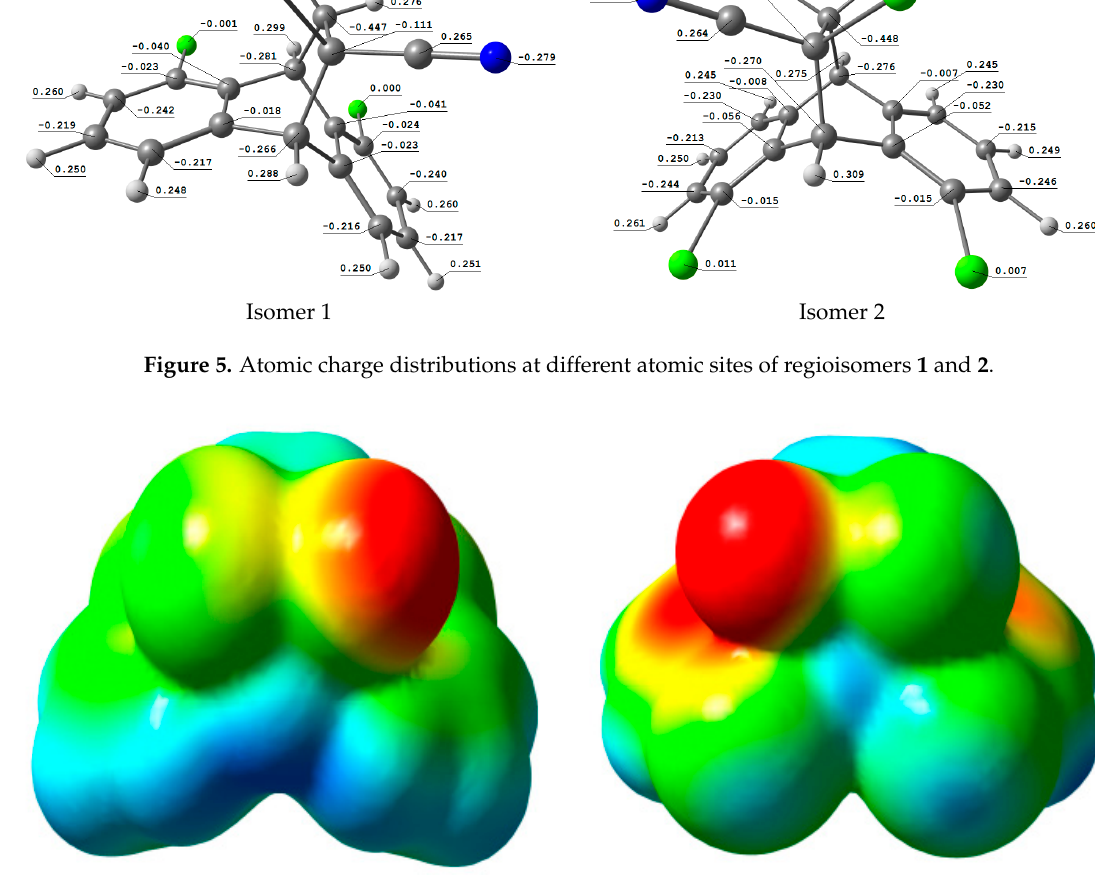
Figure 6. Electron density maps based on the molecular electrostatic potential of regioisomers 1 and 2 .